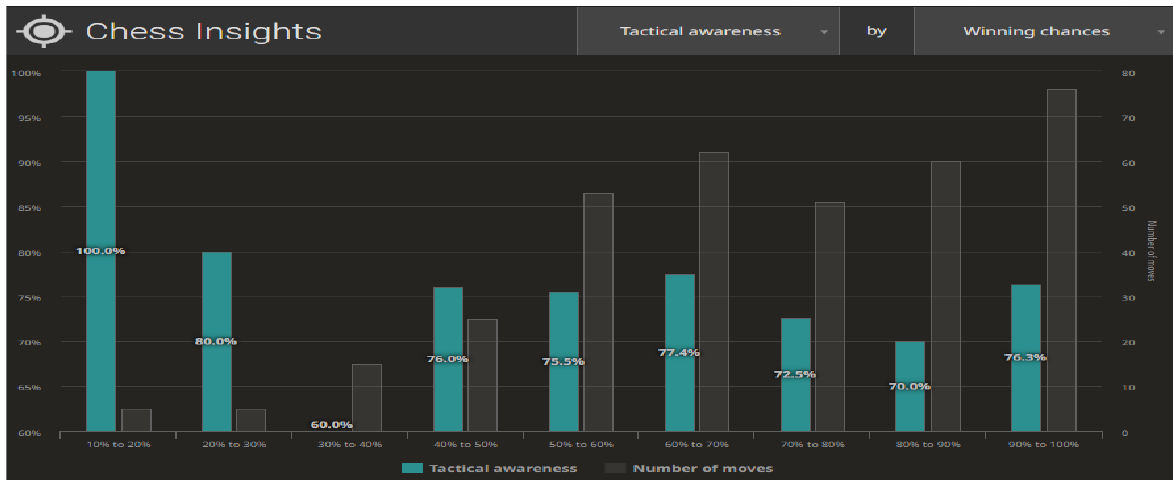
Figure 10. Statistics on making the most of opportunities to win. Source: lichess.org.